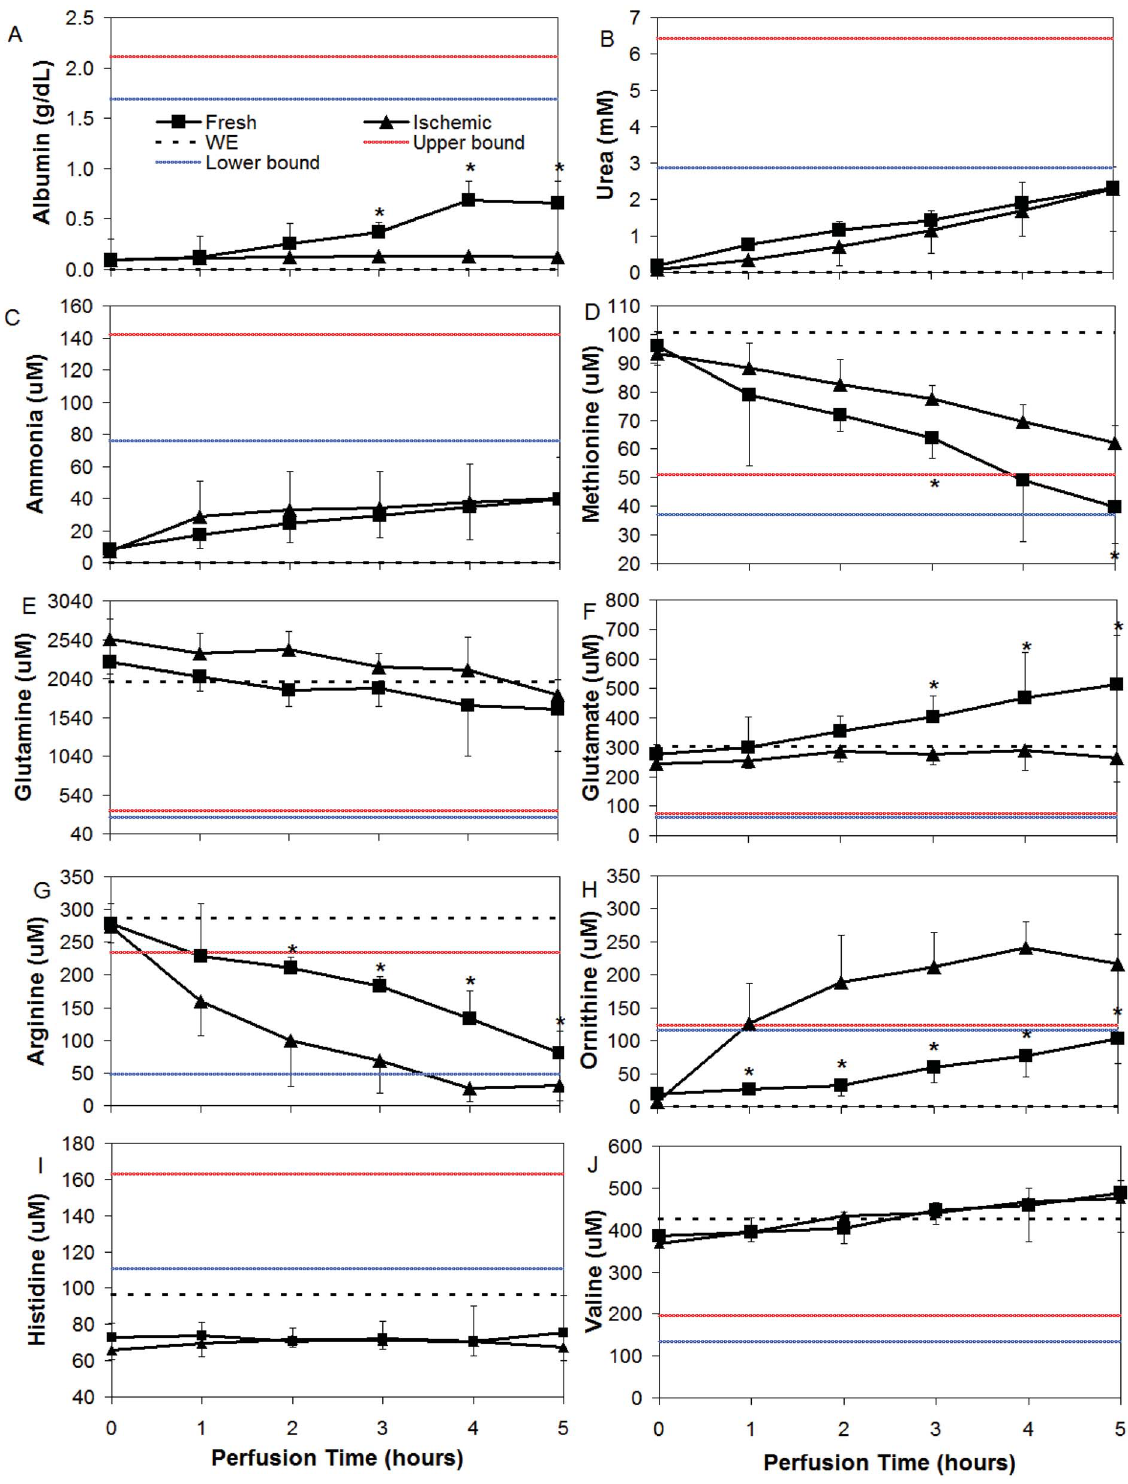
Figure 3. Average amino acid concentrations during NELP of WI and Fresh livers. Dotted line is Williams Medium E (WE), red line is in vivo upper bound (ave + 1 std dev) and blue is in vivo lower bound (ave – 1 std dev). * Indicates significantly different from Ischemic (p , 0.05). doi:10.1371/journal.pone.0069758.g003 formation of 2-oxo-glutarate (Flux # 39). This increased flux restored to a value similar to that of Fresh livers. Asparagine to converged on the TCA cycle at a point of reduced incoming fluxes aspartate production was further increased to a rate 60% greater from citrate, such that the downstream pathway of the cycle was than Fresh livers, while tyrosine, methionine and serine metabo-